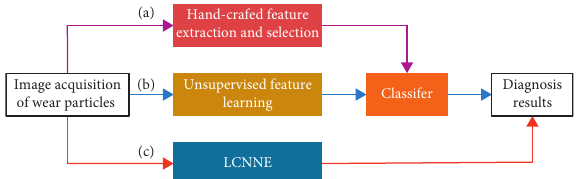
Figure 1: Three intelligent fault diagnosis frameworks: (a) tradi- tional method; (b) features extracted by unsupervised learning; (c) the proposed method: